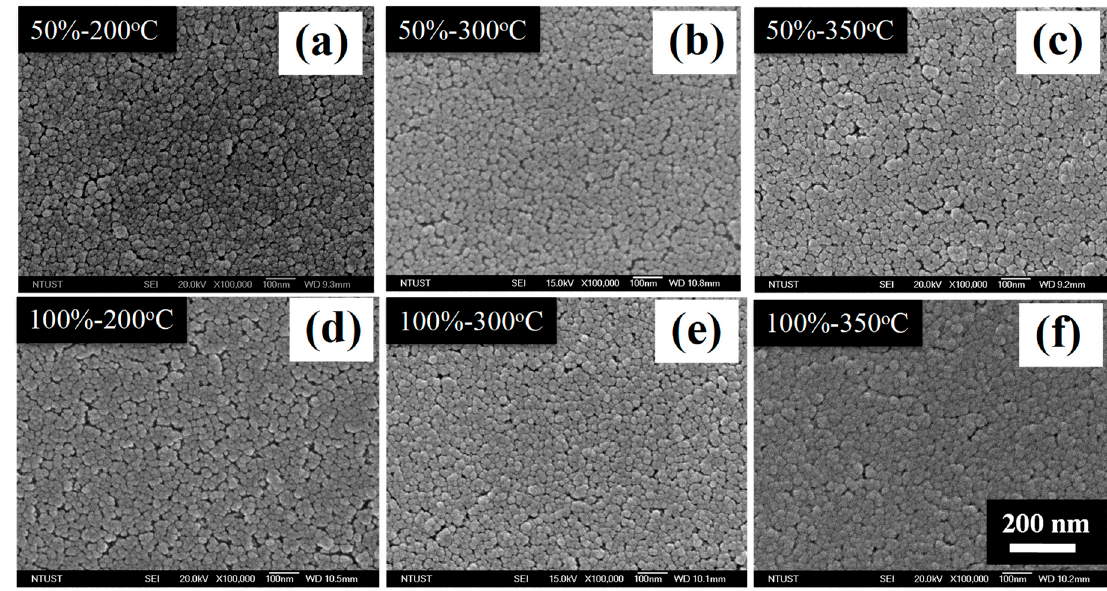
Figure 7. SEM images of top-view of C–TiO 2 films synthesized in the glucose solutions with concentrations of ( a – c ) 50%, and ( d – f ) 100% after sintered at 200, 300 and 350 °C, respectively.